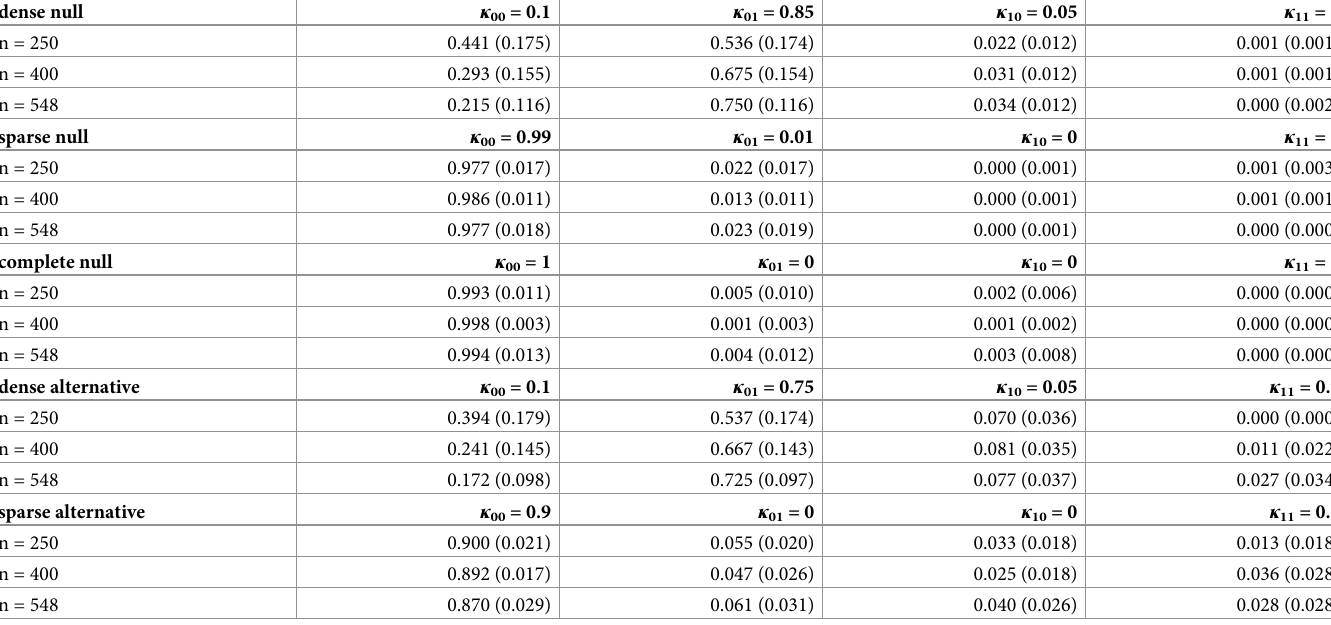
Note: κ 10 stands for the probability that the exposures are related to the mediator in the exposure-mediator model but the mediator is not associated with the survival outcome in the mediator-outcome model; κ 01 stands for the probability that the exposures are not related to the mediator in the exposure-mediator model but the mediator is associated with the survival outcome in the mediator-outcome model; κ 00 stands for the probability that the exposures are not related to the mediator in the exposure-mediator model and the mediator is not associated with the survival outcome in the mediator-outcome model; κ 11 stands for the probability of the existence of mediation effects. The number of genes (i.e., the mediators) was set to 10 4 . Note that, here we only present the estimates of one simulation scenario, with more results shown in S1 Table.